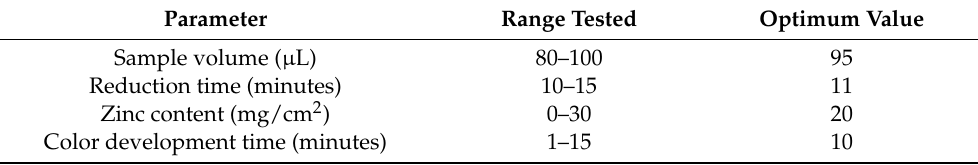
Table 1. Parameters investigated for the proposed paper-based device and their optimum